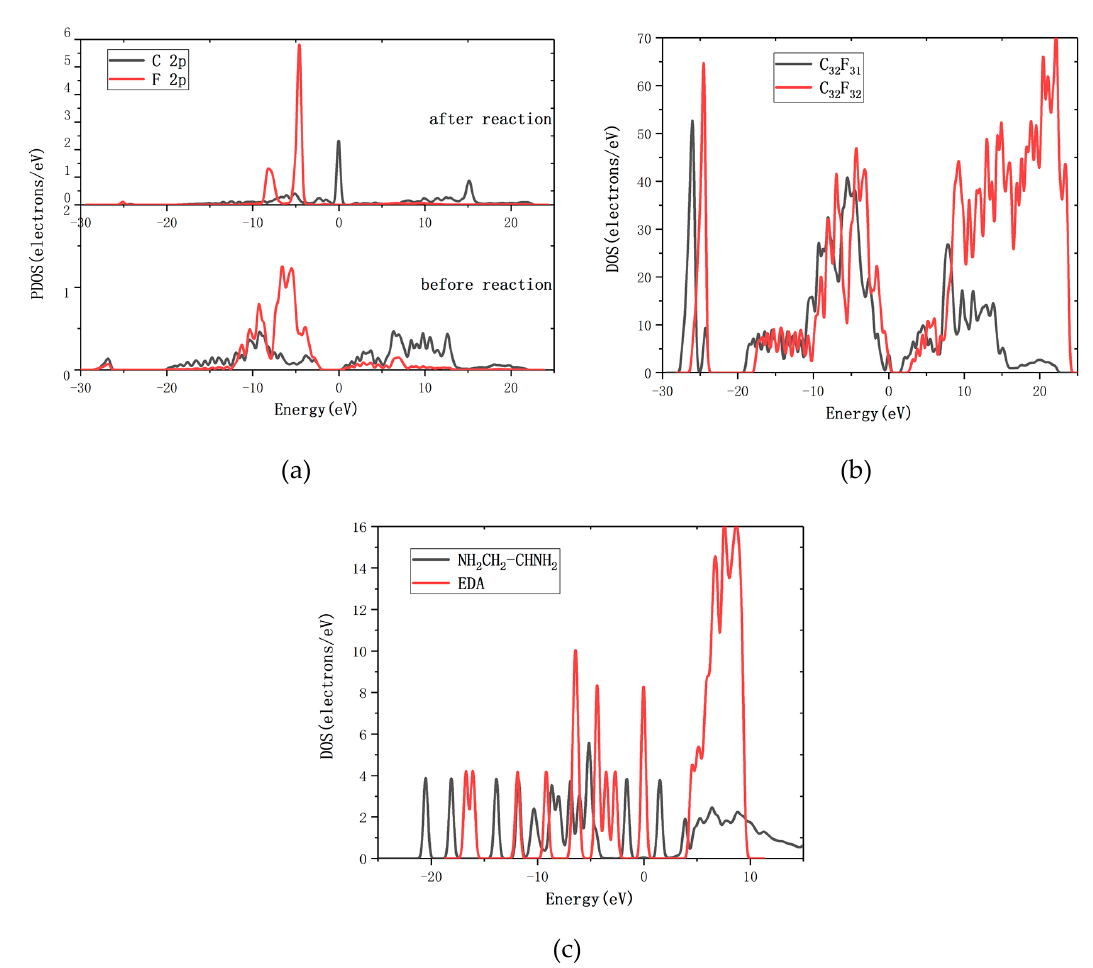
Figure 4. ( a ) The partial densities of states (PDOS) of C and F atoms on graphene fluoride before and after the reaction; ( b ) the CF DOS diagram before and after reaction; ( c ) the EDA DOS diagram before and after